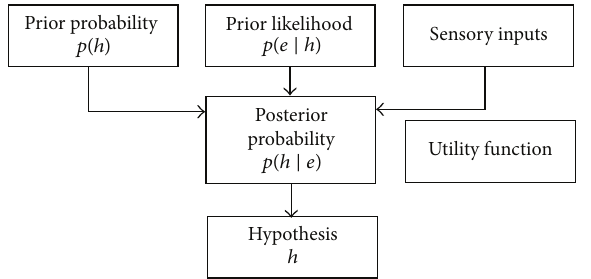
Figure 2: Typical Bayesian